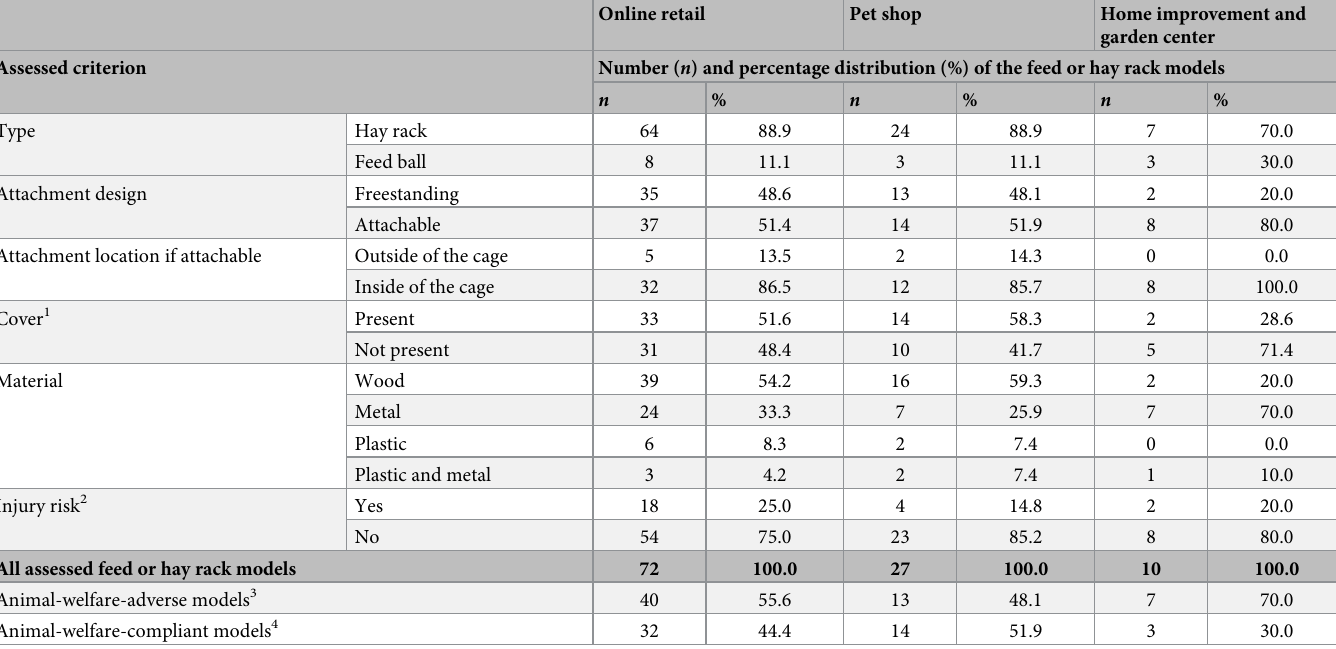
Table 5. Types and design features of feed or hay rack models purchasable from German pet supply retailers (online via internet shops, on site in pet shops or home improvement and garden